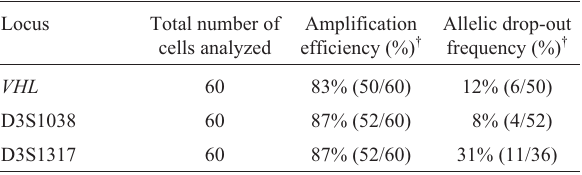
Table 2 - Polymerase chain reaction amplification efficiency and allelic drop-out rate of the Von Hippel-Lindau ( VHL ) gene and the D3S1038 and D3S1317 microsatellites in single